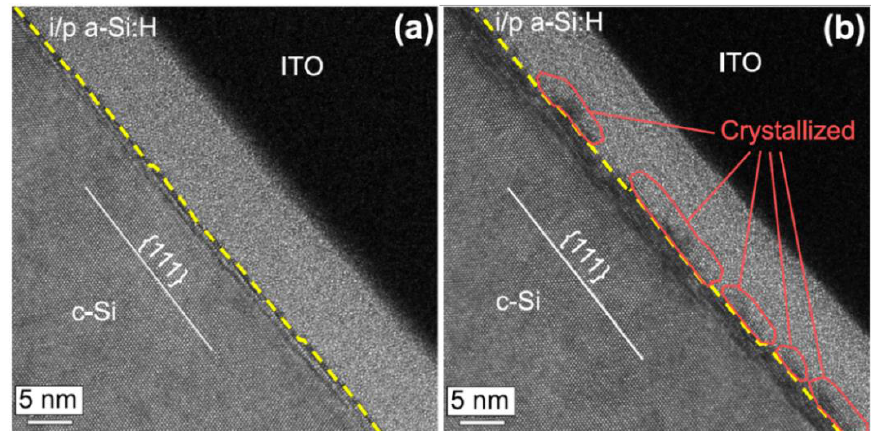
Figure 4. Cross − sectional TEM images of the interfaces between i/p a − Si:H and c − Si of the SHJ solar cells: ( a ) stack of less dense a − Si:H(i1) layer and dense a − Si:H(i2) layer, ( b ) single dense a − Si:H(i2) layer [75]. The crystallized interface indicates the epitaxial growth in the condition of a single dense a − Si:H(i2) layer.